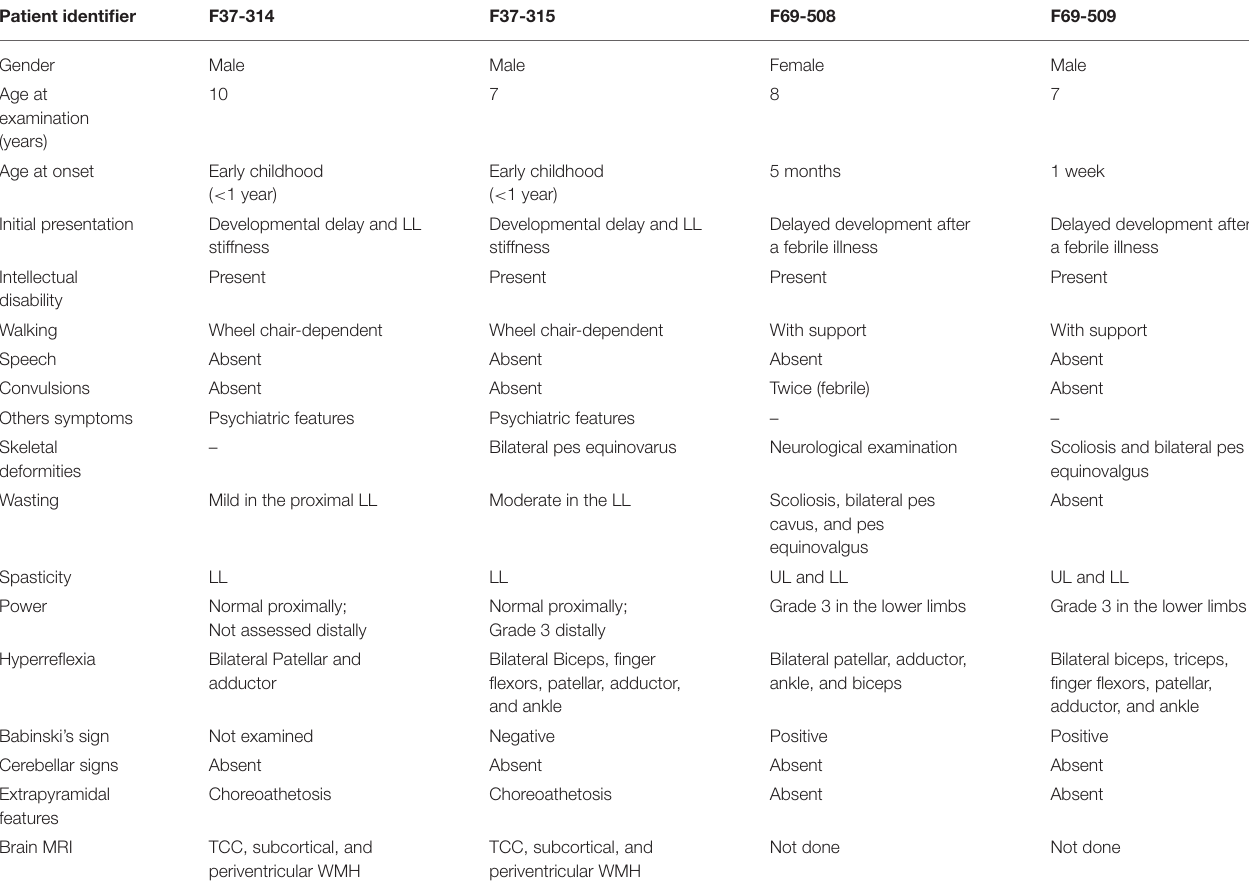
TABLE 1 | Summary of the clinical presentation of the patients from the families F37 and F69. Patient